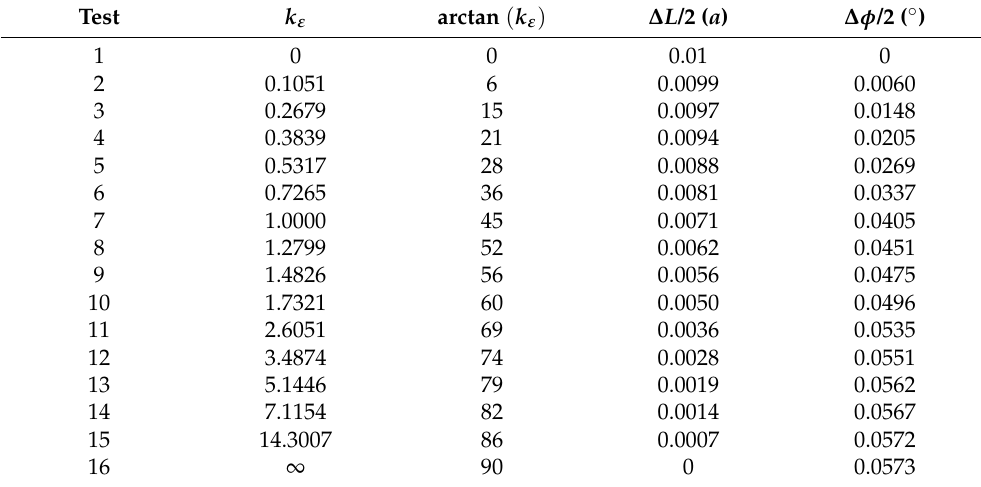
Table 1. A summary of the coupled tension–torsion loading settings for different tests.